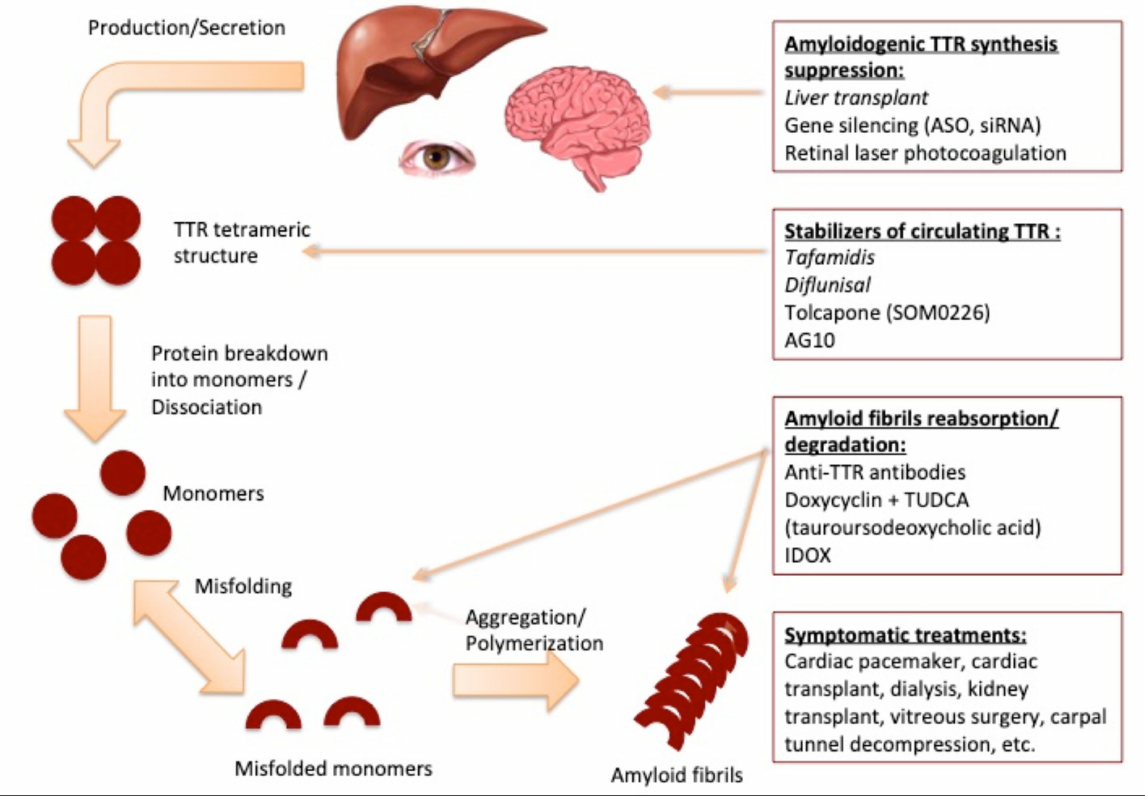
Figure 10. Steps of amyloid formation and corresponding therapeutic strategies. Modified from: Recent advances in transthyretin amyloidosis therapy, Mitsuharu Ueda and Yukio Ando